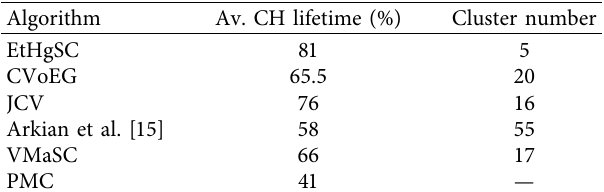
Table 3: Comparative analysis of diferent algorithms at low trafc density. Algorithm